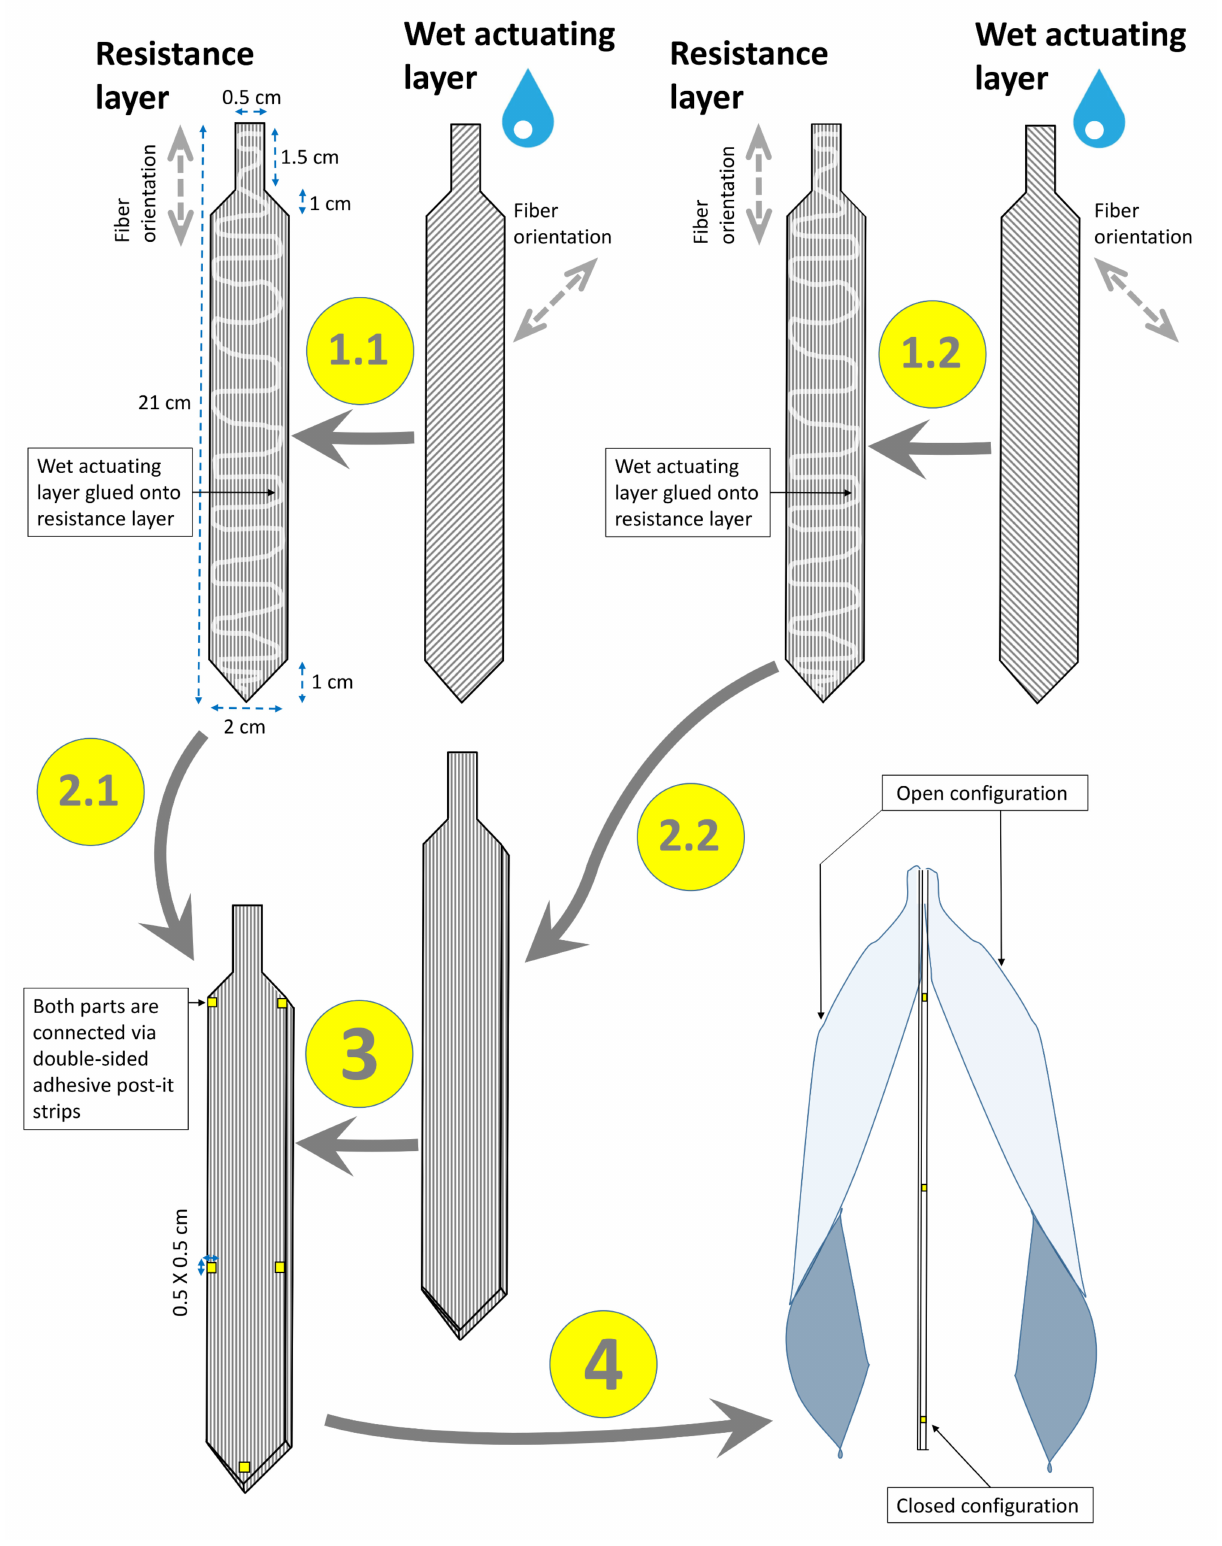
Figure 6. Exemplary construction scheme for the abstraction of the legume (Fabaceae seed pod) and its transfer into a paper-based self-actuated compliant system. The fiber orientations of the dry RLs and wet ALs are indicated (gray dashed arrows). The various construction steps are numbered (1–4). Steps 1.1/1.2 and 2.1/2.2, respectively, can be completed in any order. Details are provided in the main